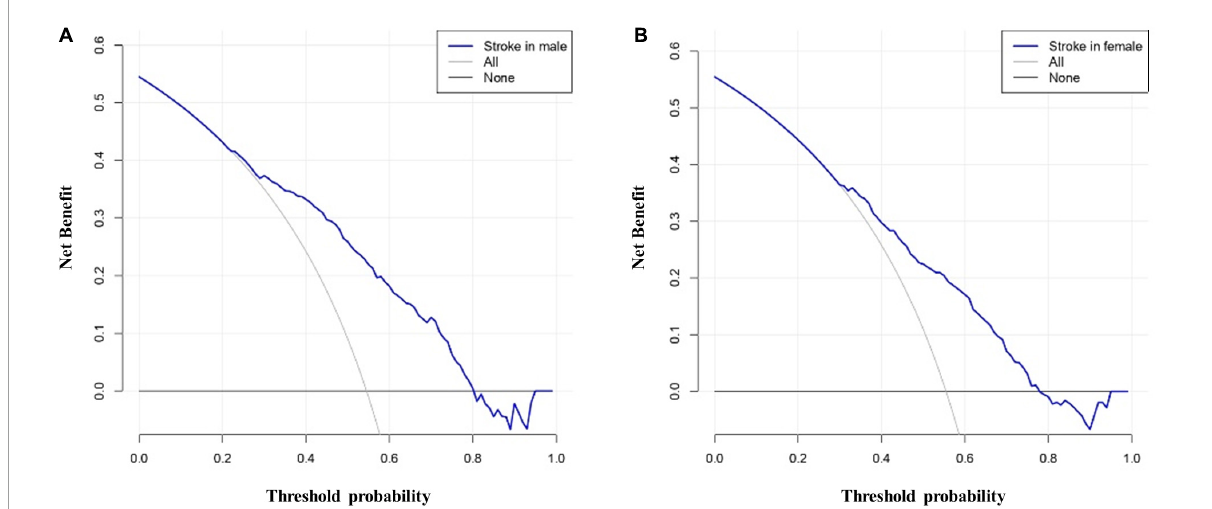
FIGURE10 Decision curve analysis whereby the y -axis represents the net benefit, and the blue line represents the risk. The thin solid line denotes the assumption that all patients had IS, while the thick solid line denotes the assumption that no patients had IS. (A) illustrates the decision curve analysis for the male patients with the highest net benefit achieved for a threshold probability ranging between 21 and 80%. (B) illustrates the decision curve analysis for the female patients with the highest net benefit achieved for a threshold probability ranging between 31 and 77%. These findings indicate that an intervention based on the risk predicted by the nomogram provided a favorable net benefit when compared to treating all patients or treating none of the